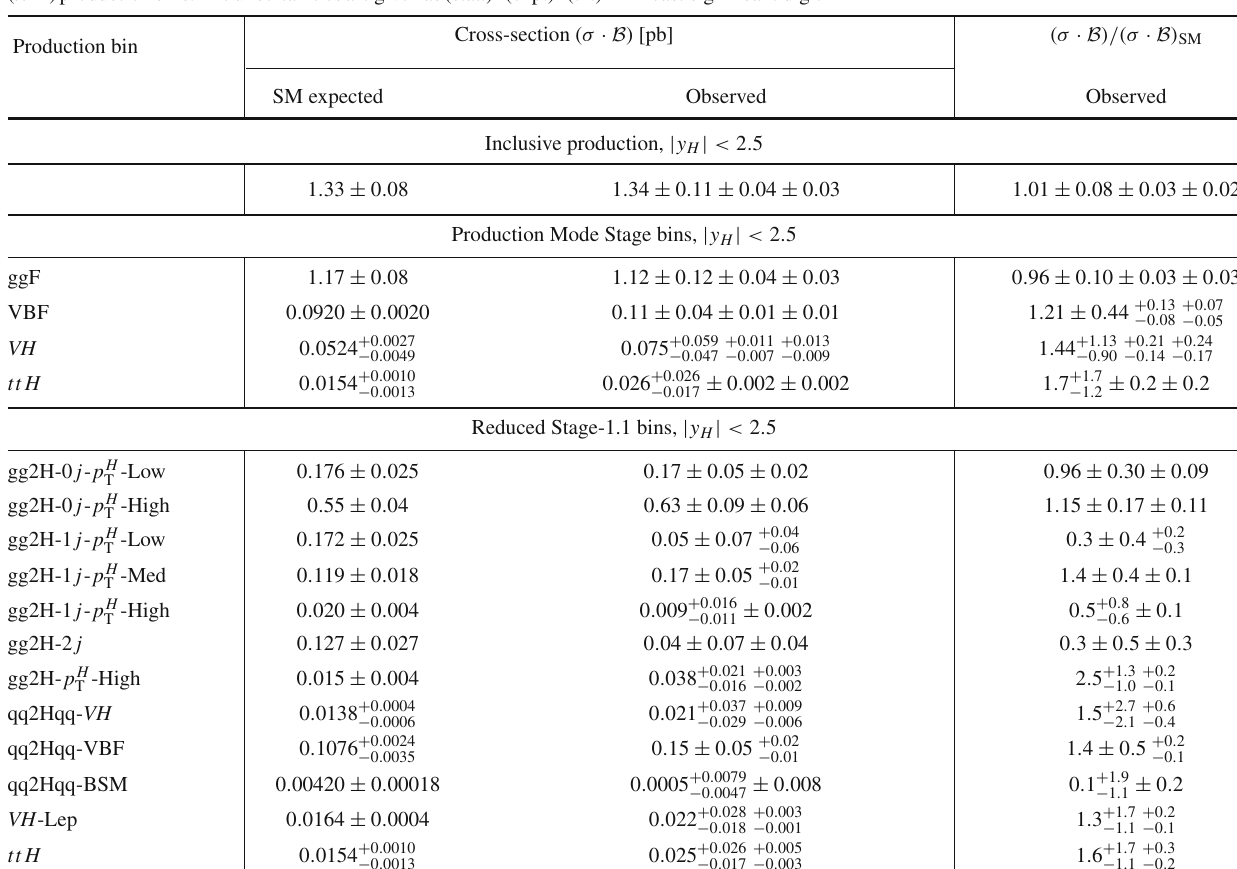
for the inclusive cross-section and the Production Mode Stage, and as (stat.)+(syst.) for the Reduced Stage 1.1. The Reduced Stage-1.1 results are dominated by the statistical uncertainty and the impact of theory uncertainties is smaller than for the Production Mode Stage. The impact of the theory uncertainties for the Reduced Stage 1.1 is smaller than the least significant